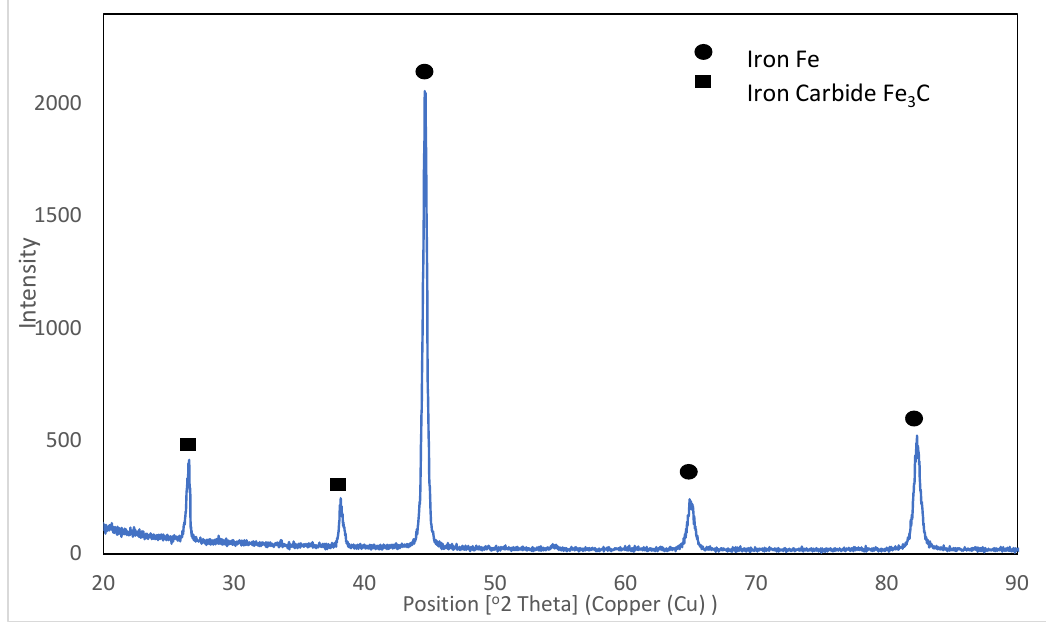
Figure 8. XRD analysis of metallic phase from experiment V3. Table 7. ICP-OES analysis of smelting product